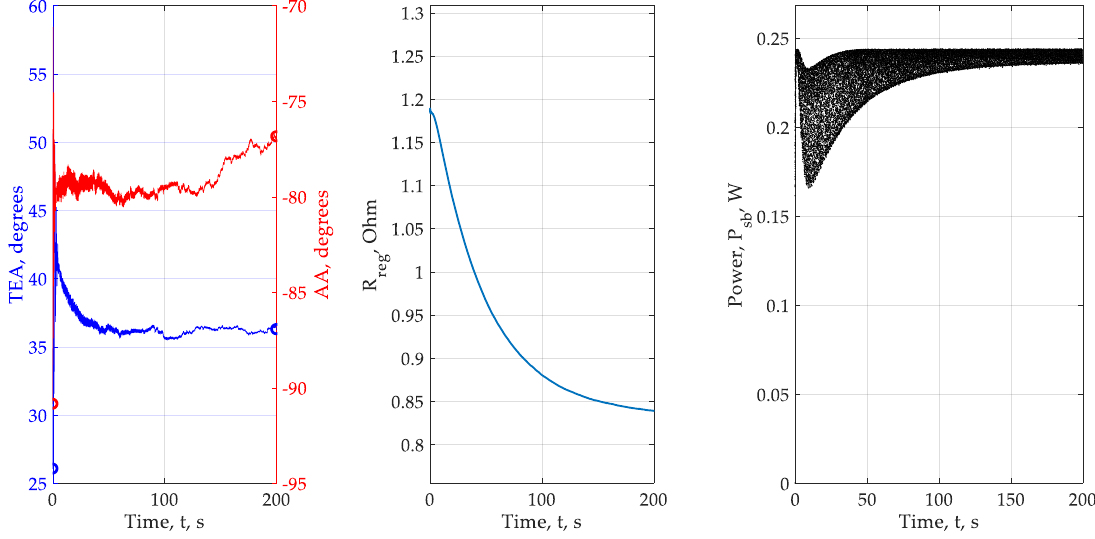
Figure 10. Experiment No.1—Kennerud, 1969.